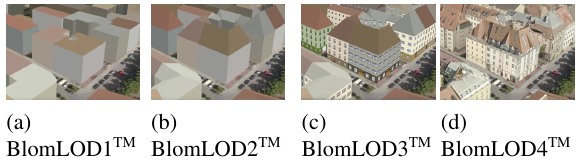
Figure 2: Example of different LoDs in BLOM3D TM . Source: Blom ASA (2011).